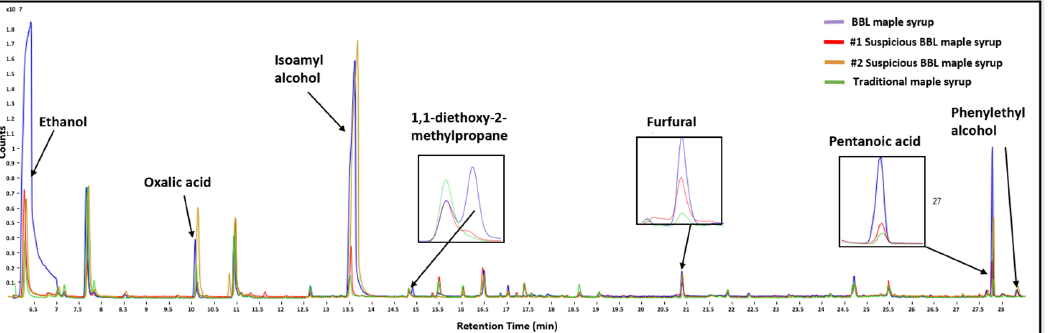
Figure 2. Representative GC ‐ MS chromatograms of volatile compound profiles for BBL maple syrup, suspicious BBL maple syrup and traditional maple syrup.